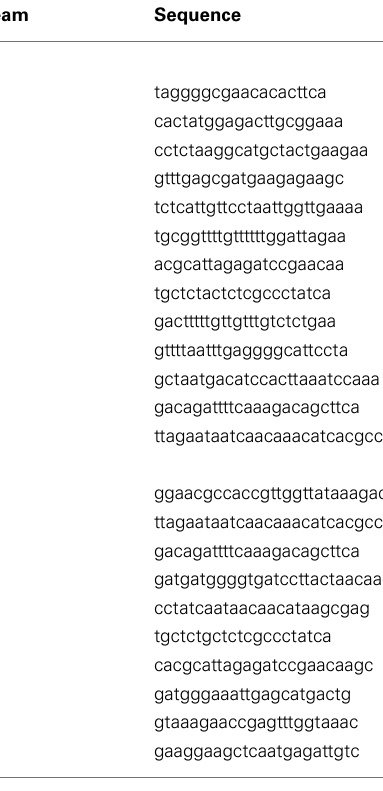
TableA4 | Primer pairs used to generate amplicons for cag PAI